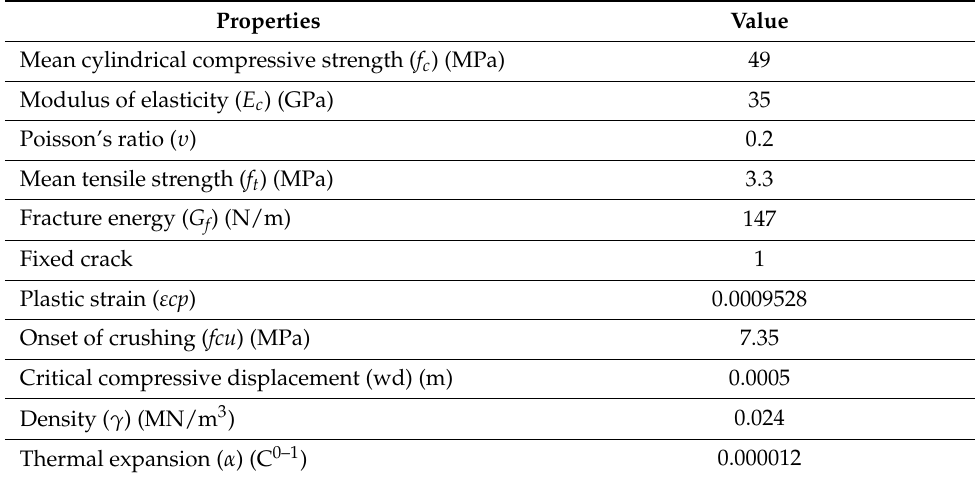
Table 6. Properties of concrete.